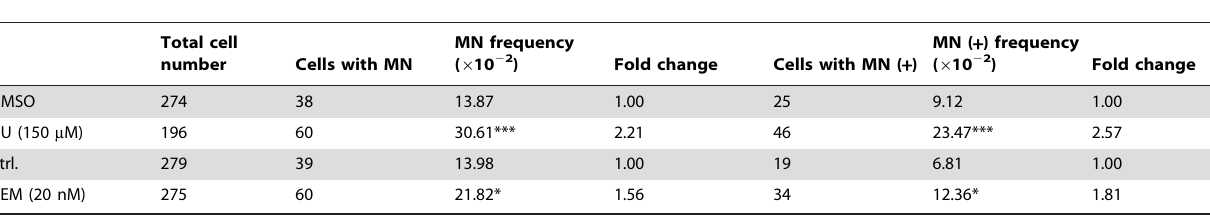
Table 1. Induction of MN and MN ( EIF5A2 + MYCN + MCL1 + ) by HU and GEM.